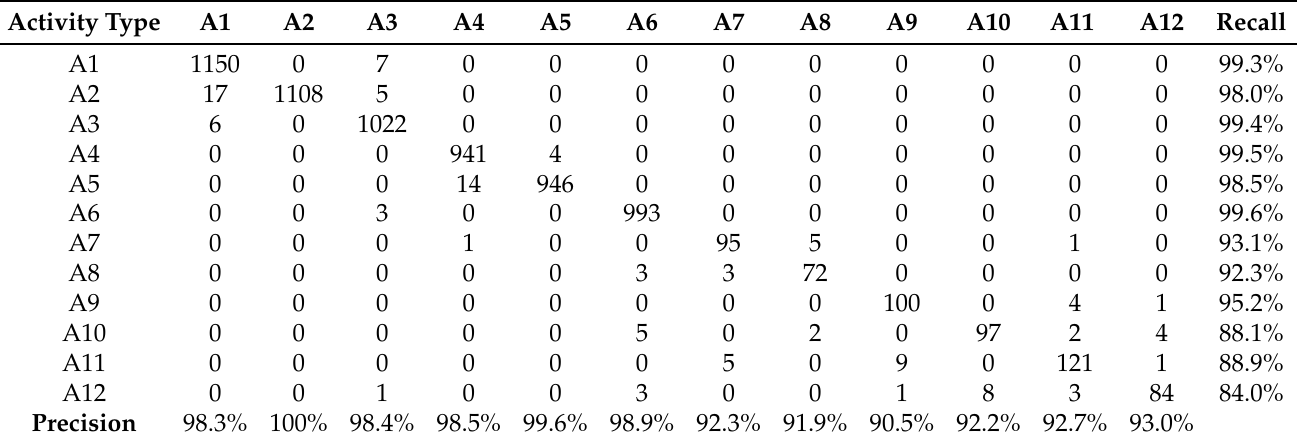
Table 4. The confusion matrix Support Vector Machines (SVM) algorithm-based.